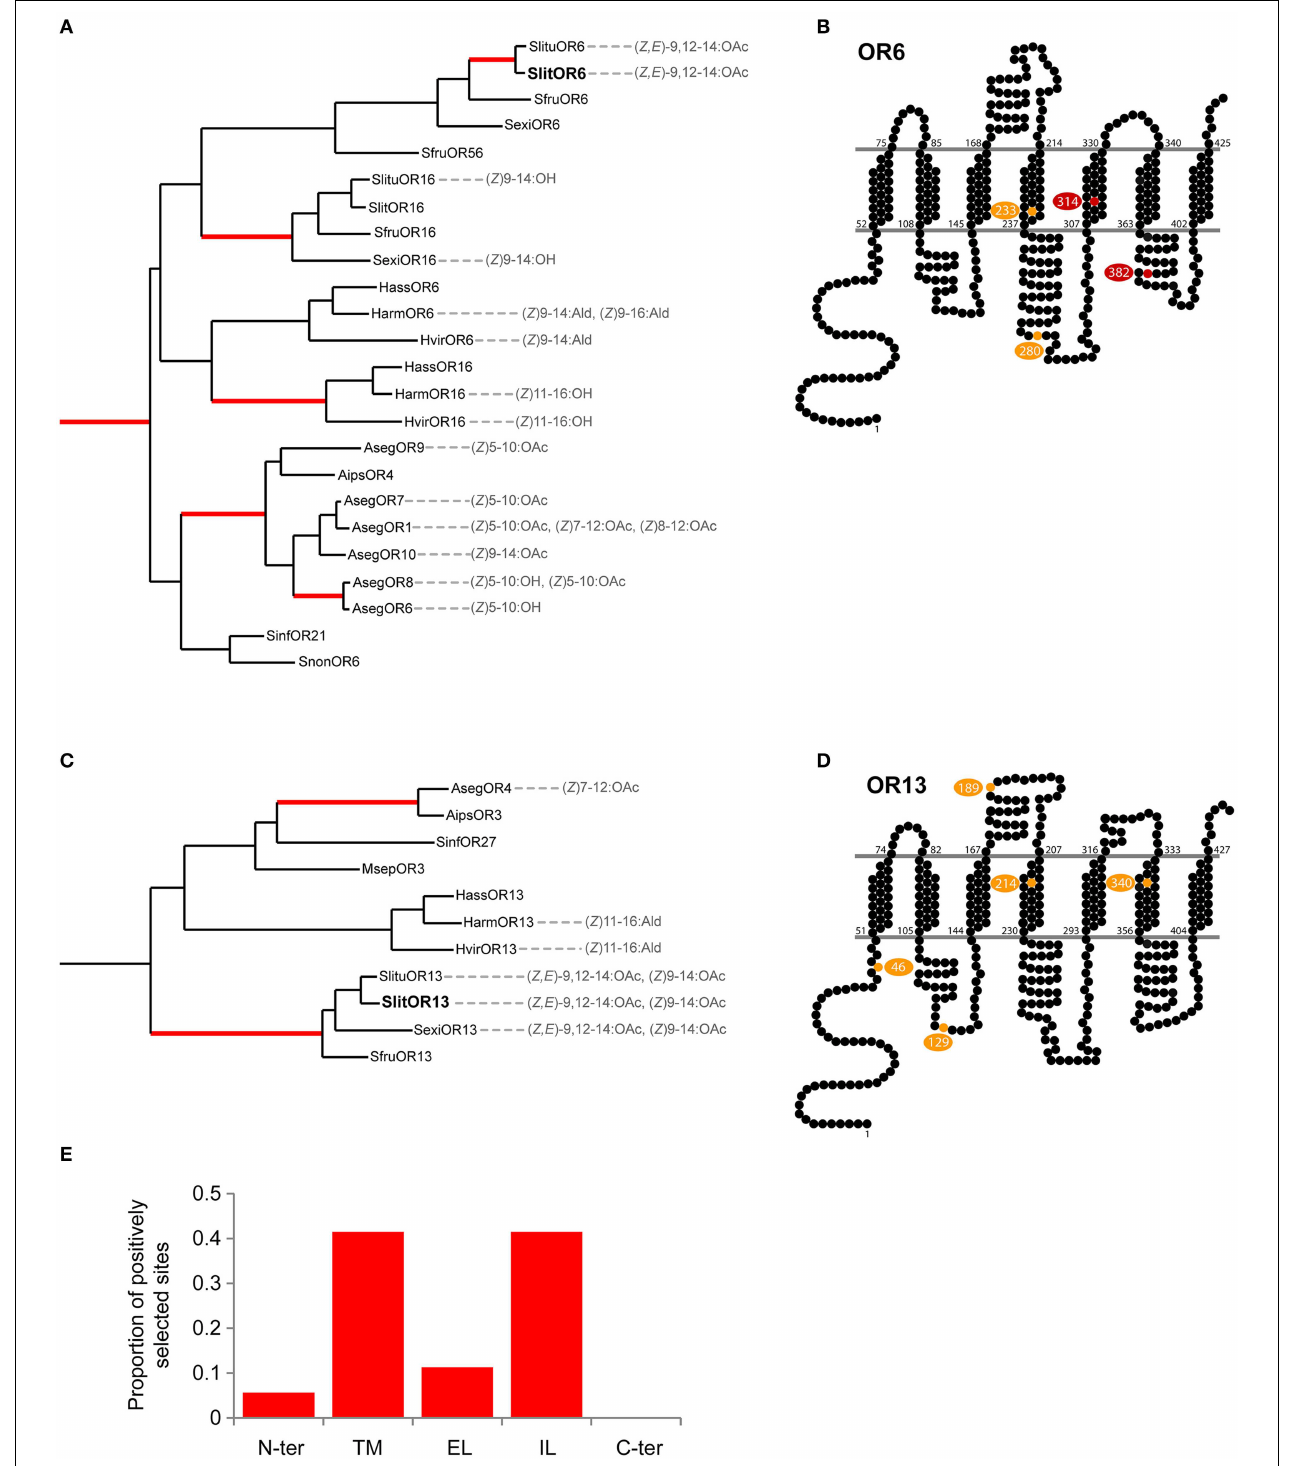
FIGURE 5 | Analysis of positive selection acting on PR genes. (A,C) Detail of clades containing Spodoptera OR6 and OR13 orthologs, showing branches (in red) in which there is evidence of positive selection. Ligands indicated are the best ligands found during the functional characterization of PRs (Wang et al., 2011; Liu et al., 2013a,b; Zhang and Lofstedt, 2013; Zhang et al., 2015). (B,D) Putative